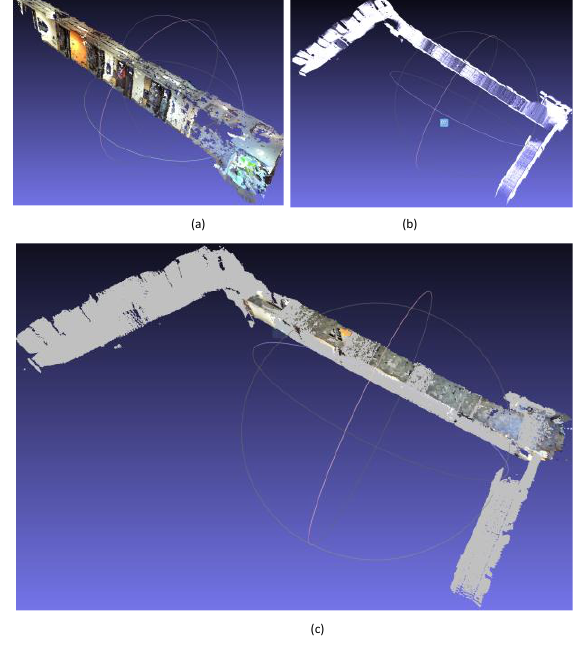
Figure 6. Generated 3D models from the first dataset. (a) RGB image-based 3D model, (b) depth-based 3D model, and (c) registered 3D model